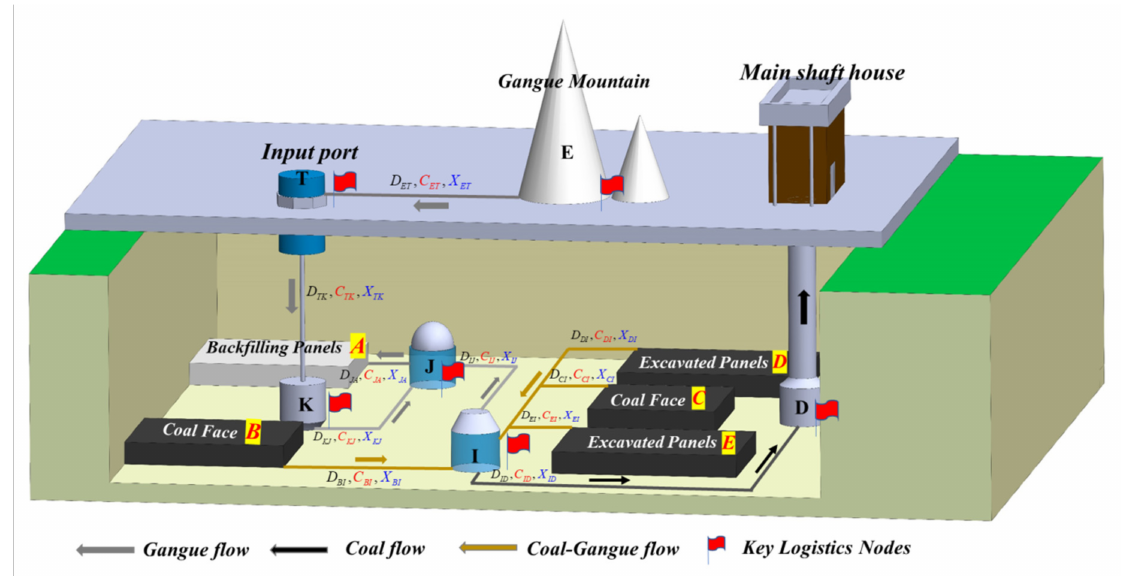
Figure 1. Node transportation model of the coal gangue backfilling